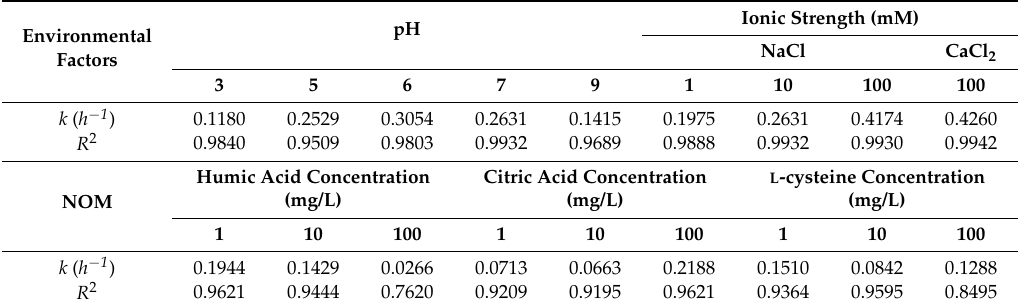
Table 1. Dynamic fitting of CuO NPs with different pH, electrolyte, and natural organic matter (NOM) contents in the aqueous